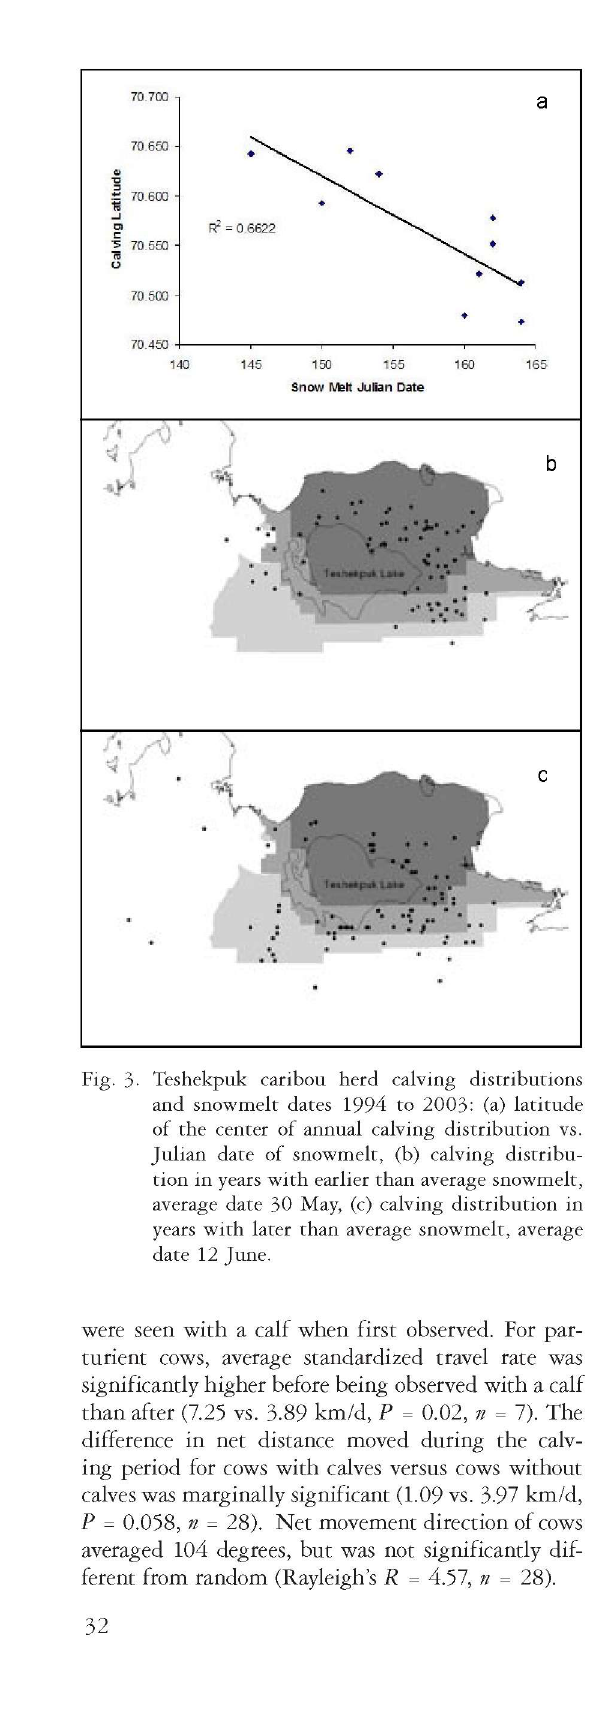
were seen with a calf when first observed. For par turient cows, average standardized travel rate was significantly higher before being observed with a calf than after (7.25 vs. 3.89 km/d, P = 0.02, n = 7). The difference in net distance moved during the calv¬ ing period for cows with calves versus cows without calves was marginally significant (1.09 vs. 3.97 km/d, P = 0.058, n = 28). Net movement direction of cows averaged 104 degrees, but was not significantly dif ferent from random (Rayleigh's R = 4.57, n = 28).